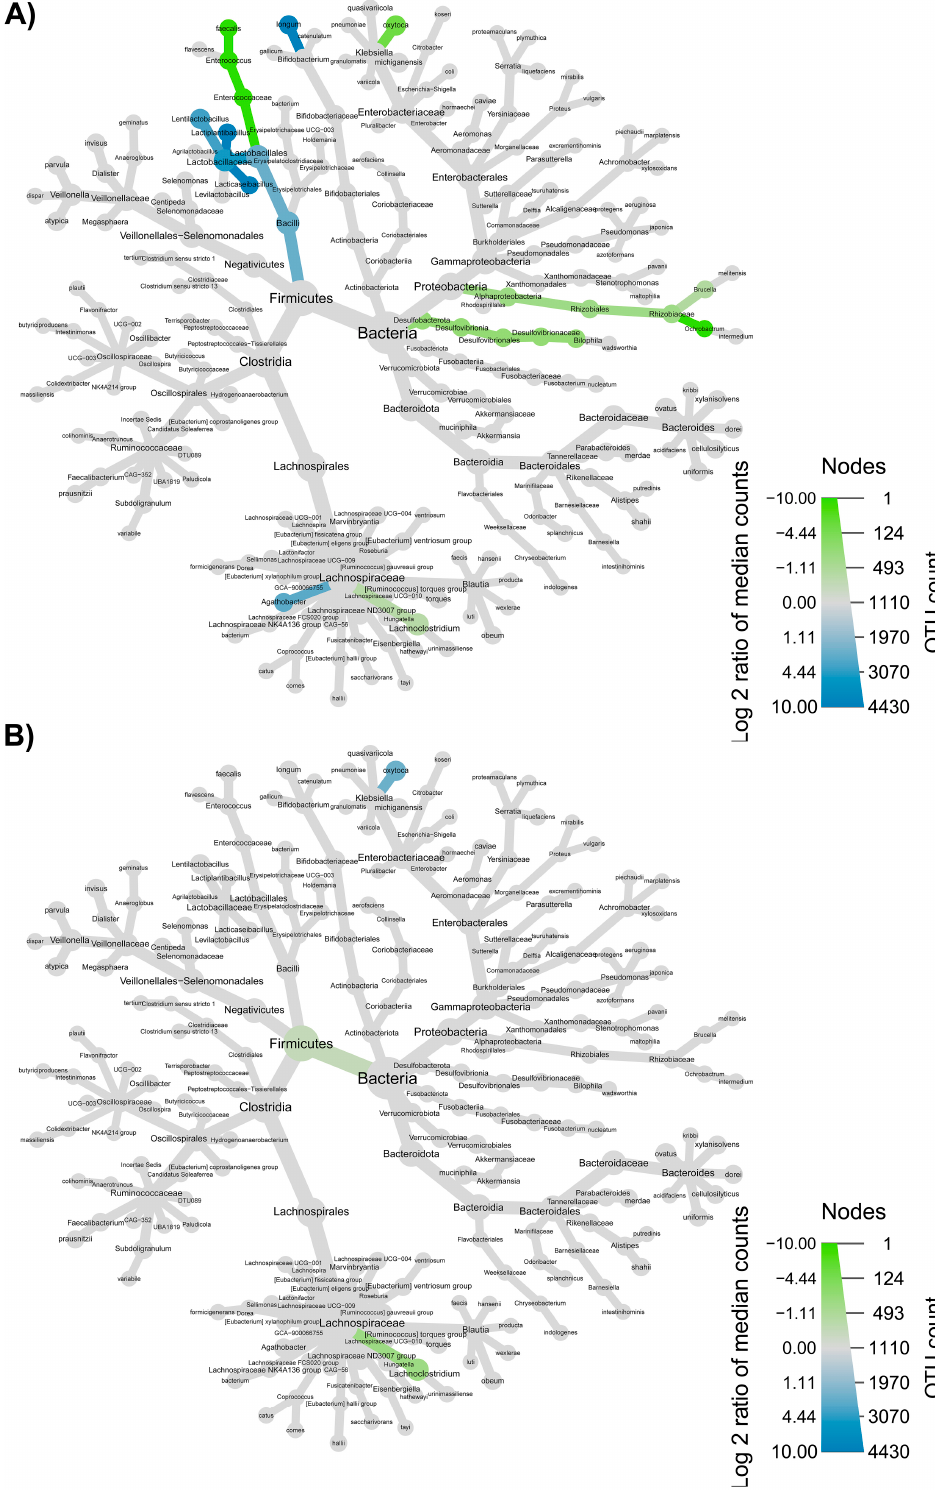
Figure 8. Microbial community taxonomic structure variations at different levels, before compared to after feeding with MWB ( A ), and before feeding against the end of wash out period ( B ). Node size denotes the rarefied ASV count, and colored nodes indicate a significant ( p < 0.05) fold change for a given taxon: green color means that the taxon is differentially abundant before the treatment, while blue color indicates that the taxon is differentially abundant after feeding ( A ) or after wash out period ( B ). Color intensity is proportional to the fold